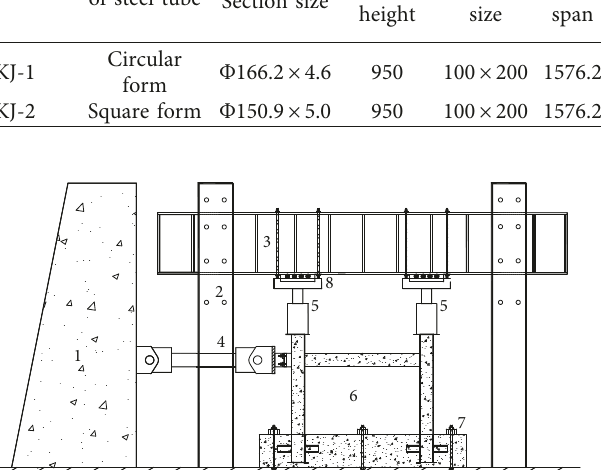
Figure 2: Loading device areas. 1: reaction wall of reinforced concrete; 2: steel column of vertical reaction; 3: reaction steel beam, connected with reaction steel column by high-strength bolt; 4: electrohydraulic servo actuator; 5: hydraulic jacks; 6: specimen; 7: pressure beam of steel structure; 8: roller